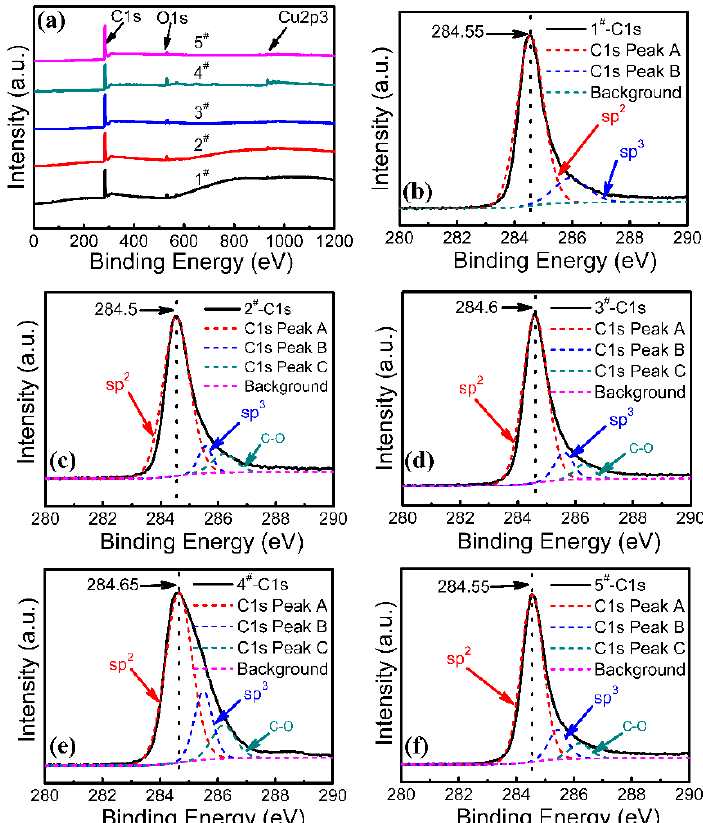
Figure 3. ( a ) X-ray photoelectron spectra (XPS) spectra from graphene grown using different number of pulses. ( b – f ) C 1s peaks in graphene from samples 1 # –5 # , respectively.